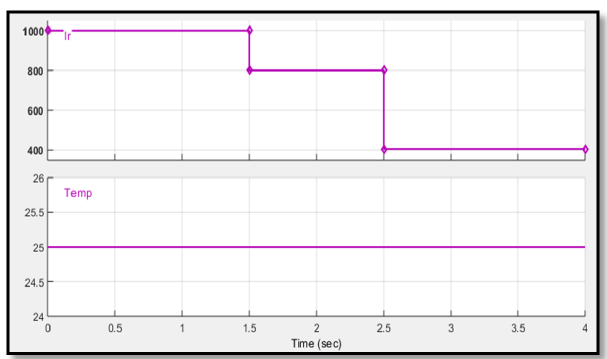
Figure 10. Irradiance and temperature for solar PV. Electronics 2021 , 10 , 2541